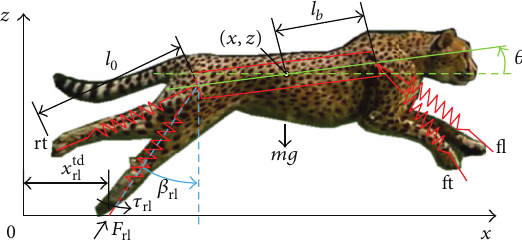
Figure 1: The simplified quadruped model of a cheetah.